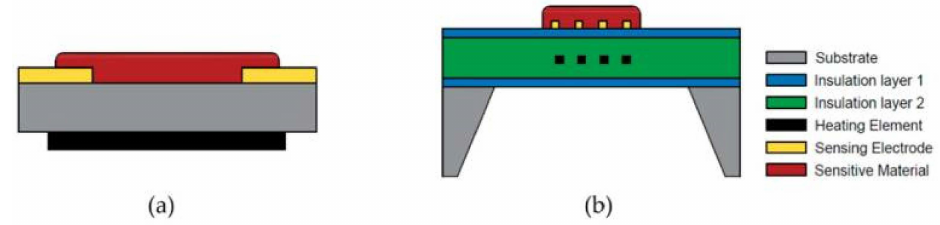
Figure 4. Schematic representations of ( a ) a common metal oxide gas sensor and ( b ) a micro-hotplate metal oxide gas sensor. Reprinted from